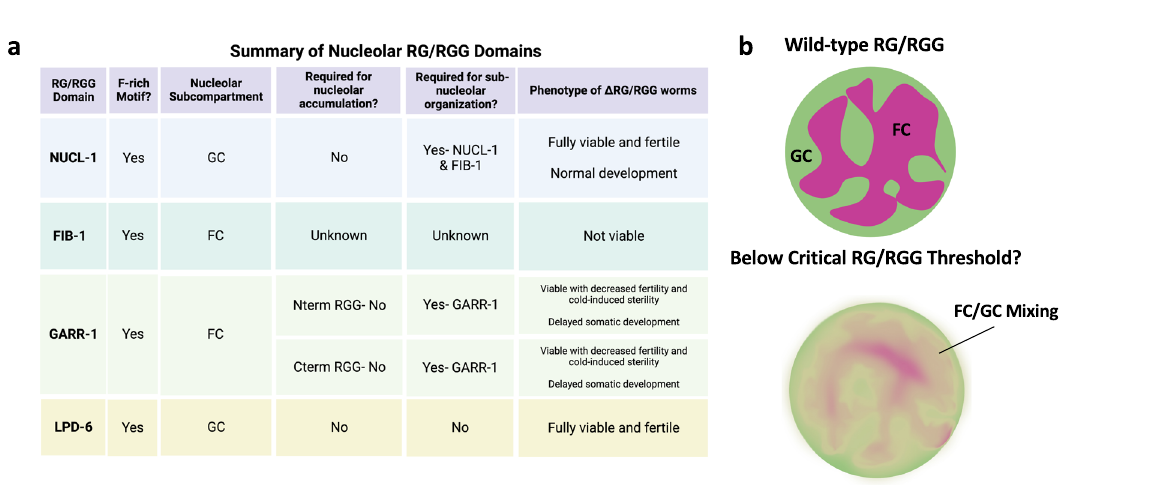
Fig. 8 | RG/RGG repeatfunction in the C.elegans nucleolus.a Summary chartof nucleolar RG/RGG domain localization and functions. b RG/RGG domains are cri- tical for large-scale compartmentalization of FC and GC regions in C. elegans nucleoli. Loss of certain RG/RGG domains (NUCL-1, GARR-1) may bring the